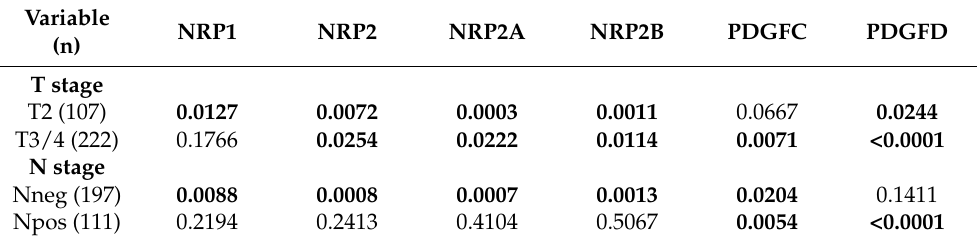
Table 5. Summary of Kaplan–Meier analyses for overall survival in the TCGA cohort after stratifica-